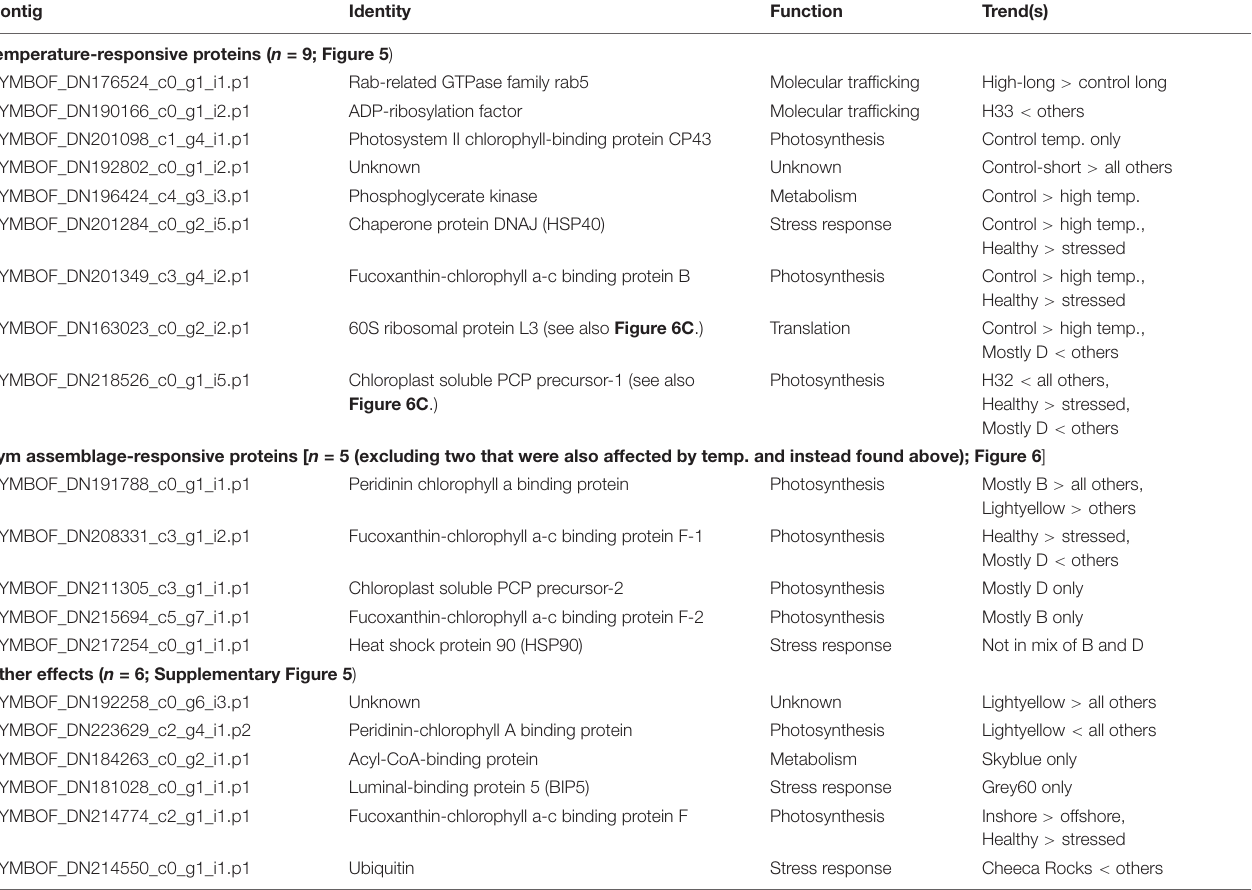
TABLE 4 | Symbiodiniaceae (Sym) differentially concentrated proteins. Contig Identity Function Trend(s) Temperature-responsive proteins ( n = 9; Figure 5